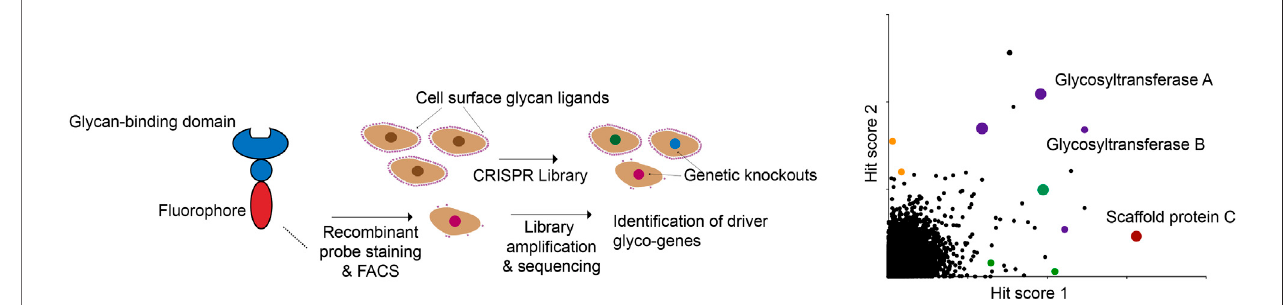
FIGURE 4 | A modular CRISPR screening strategy for identifying genes that regulate binding of a lectin to the surface of living cells. The abundance and ready availability of different glycan-binding proteins that can be adapted for this assay make this a general approach to glyco-genomics research.